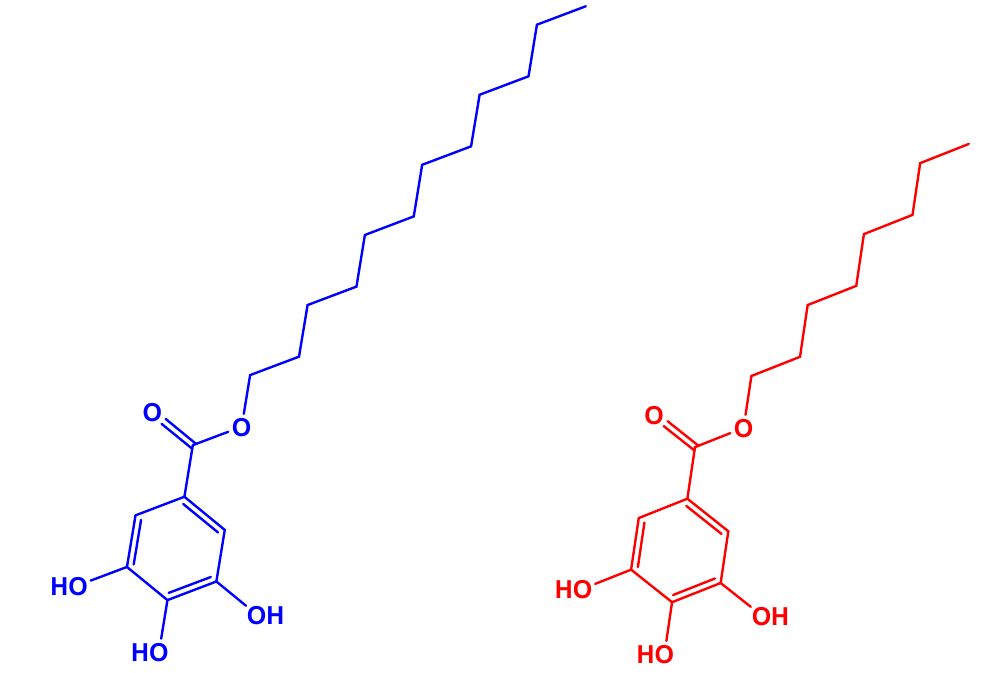
Figure 6. Chemical structure of Lauryl Gallate (LG) and Octyl Gallate (OG).